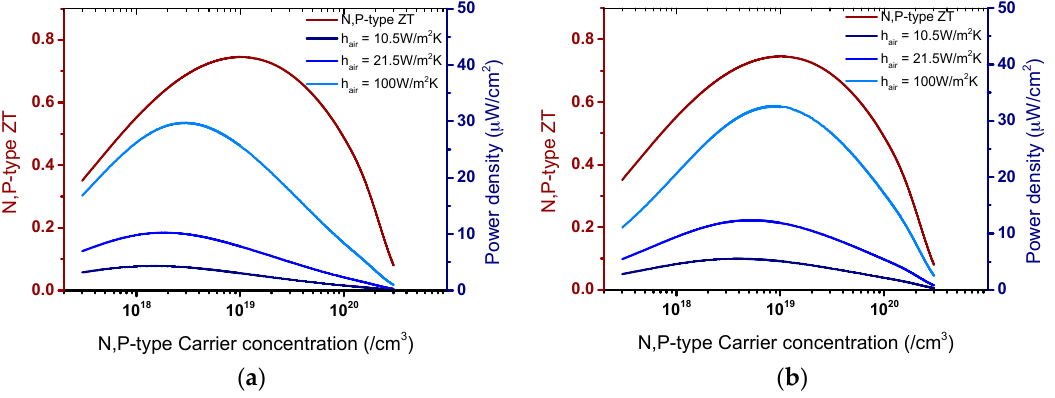
Figure 7. The power density distribution of ( a ) material D and ( b ) material A based TEG with variation of the convective heat transfer coefficient between TEG and air ( h air ).